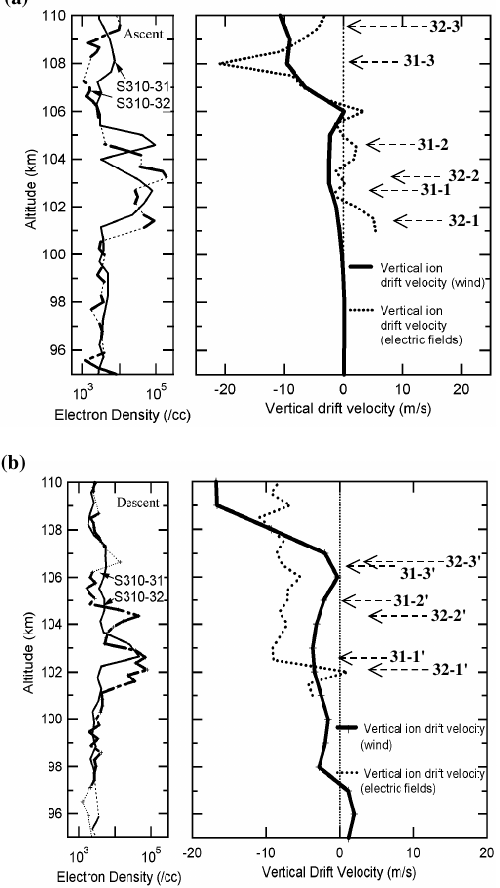
Fig. 5. (a) Comparison between the electron density profiles and ion vertical velocity. Here the ion vertical velocity is deduced from both the neutral wind (S310-32) and electric field data (S310-31). The peak 32-1 is in the ion accumulation region by the wind and the electric field but peaks 31-2 and 32-2 are in the region due to the elctric field alone. The 31-3 peak is slightly above both accumula- tion regions. The peaks 31-1 and 32-3 are also in the regions due to netural wind accumulation. (b) The same as Fig. 5a, except for the descending phase. The 31-1 0 , 31-3 0 , 32-1 0 , and 32-3 0 peaks are in the accumulation region due to neutral wind and the electric field. The 32-2 0 is with the accumulation region due to the electric fields. The 31-2 0 does not correspond to both accumulation